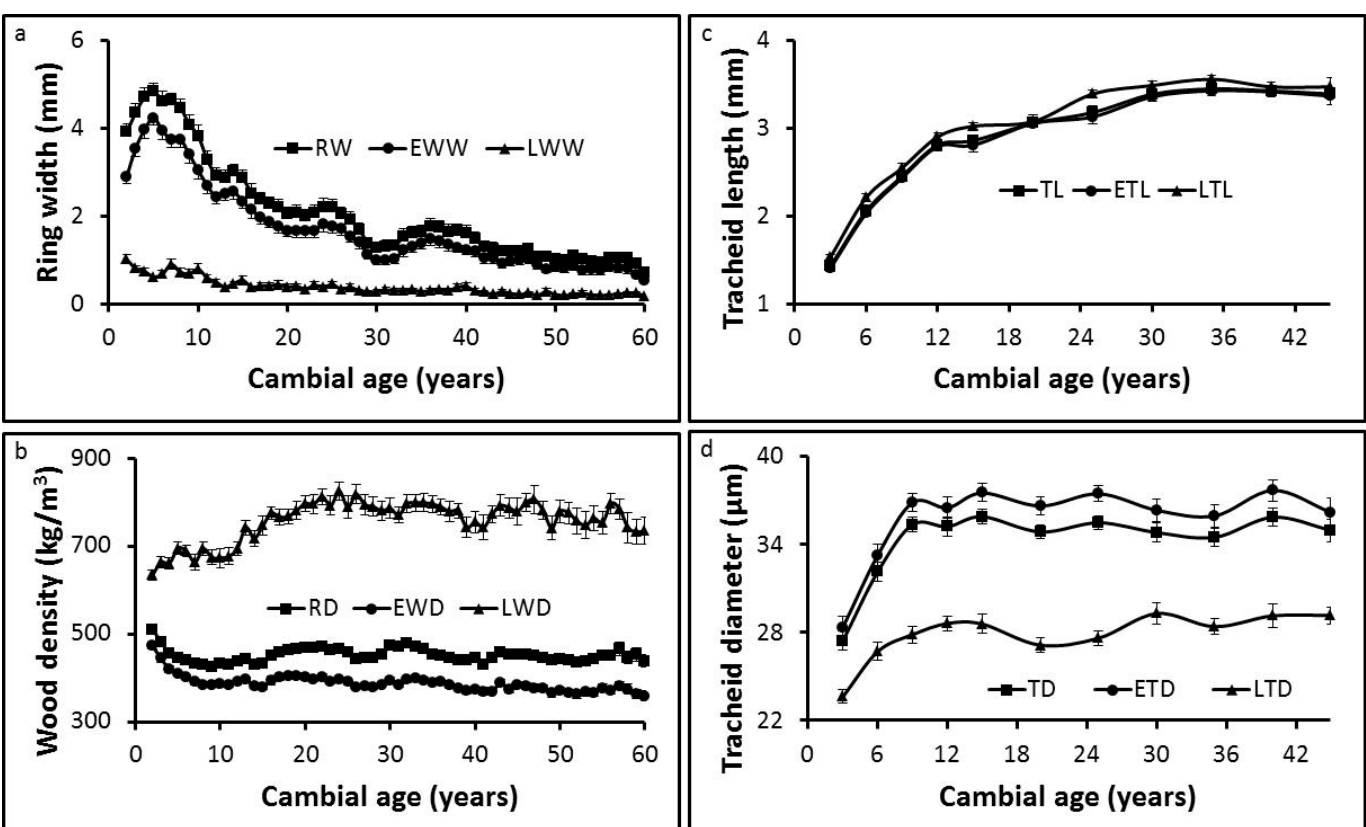
Figure 1. Intra-ring and inter-ring radial variations of growth-related, density-related, and anatomical wood properties: ( a ) Ring width (RW), earlywood width (EWW), and latewood width (LWW). ( b ) Ring density (RD), earlywood density (EWD), and latewood density (LWD). ( c ) Average ring tracheid length (TL), earlywood tracheid length (ETL), and latewood tracheid length (LTL). ( d ) Average ring tracheid diameter (TD), earlywood tracheid diameter (ETD), and latewood tracheid diameter (LTD). Bars indicate standard errors of the mean.